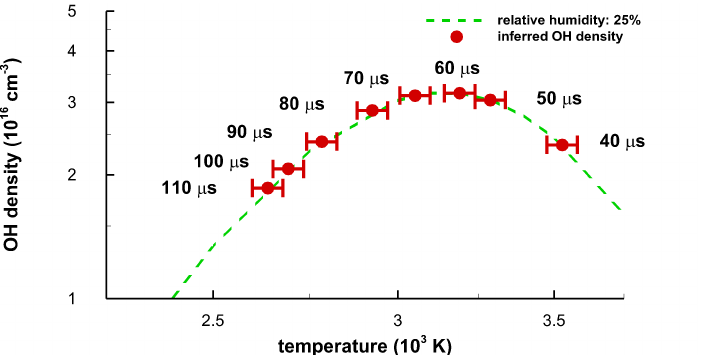
Figure 15. Equilibrium density of OH versus average temperature for a relative humidity of 25 percent. The data points correspond to the indicated time delays. Maximum OH density of 3.17 × 10 16 cm − 3 occurs at a temperature of 3.144K. The occurrence of the OH density maximum is a result from equilibrium chemistry calculations as function of temperature. Table 1. Mole fractions for T = 2500 K, T = 3100 K, and T = 3750 K, from computation of air species with the CEA-program, and for 25% relative